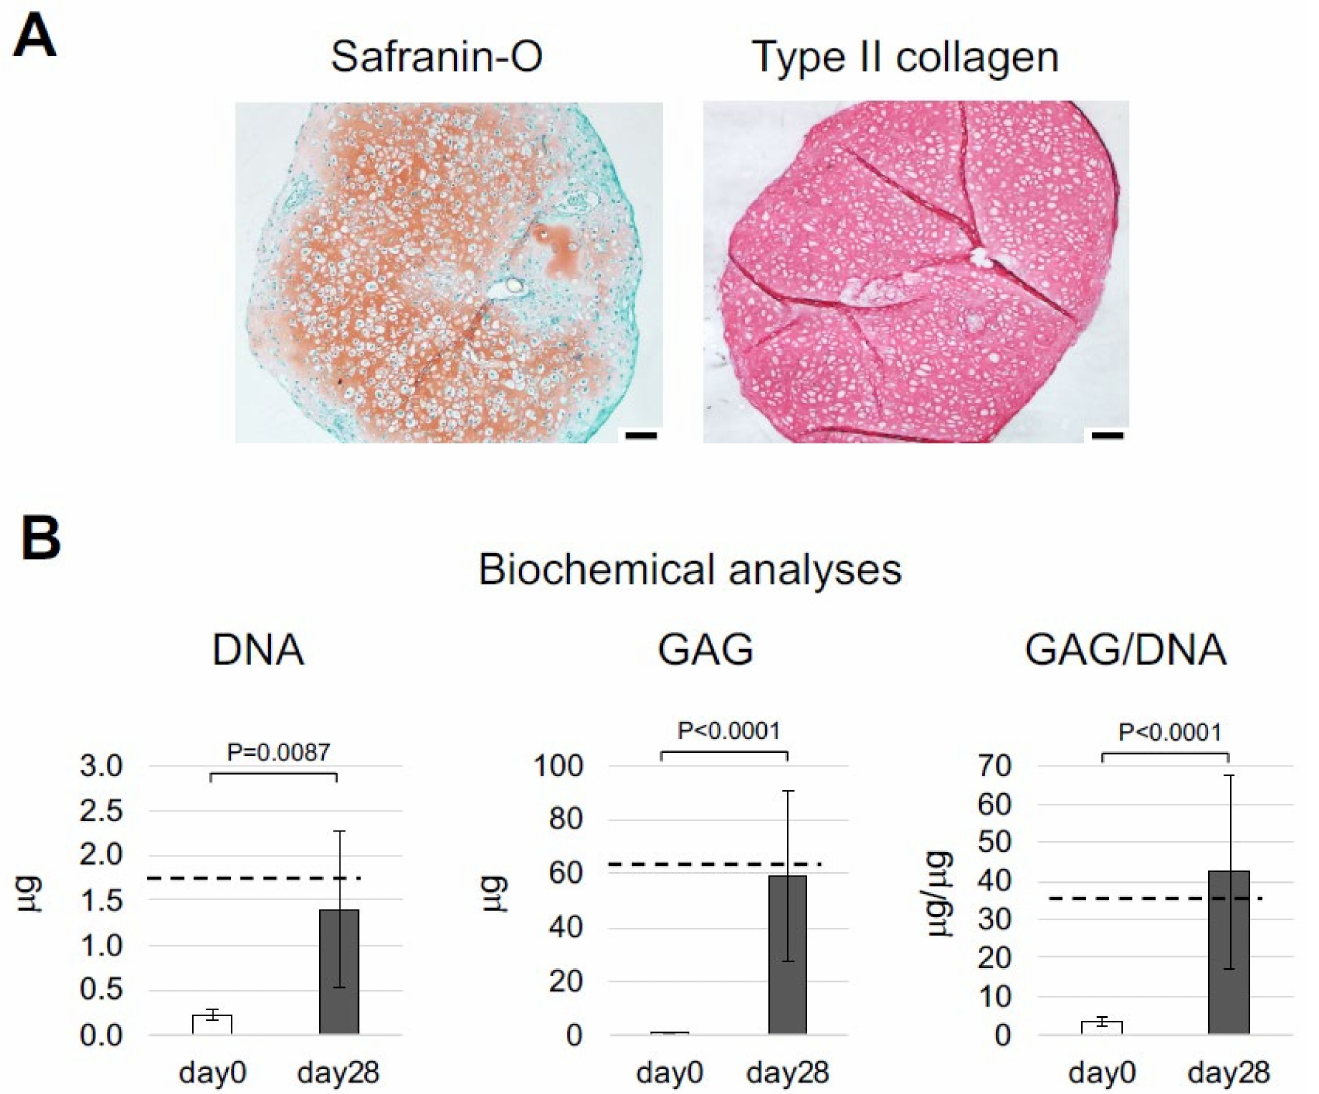
Figure 2. Chondrogenic capacity of nasoseptal chondrocytes (NCs) generated after the rapid iso- lation protocol. Freshly isolated NCs were cultured in pellets in medium containing human platelet lysate (hPL) for 28 days. ( A ) Representative Safranin-O and type II collagen staining of resulting cartilaginous tissues. Scale bars = 100 µ m. ( B ) Glycosaminoglycans (GAG), DNA and GAG/DNA contents of generated cartilaginous tissues. Values are mean ± SD of results of samples generated with cells from seven different donors. Dash lines represent the mean values of the parameters measured in control pellets generated by passage 2 standard isolated NCs at day